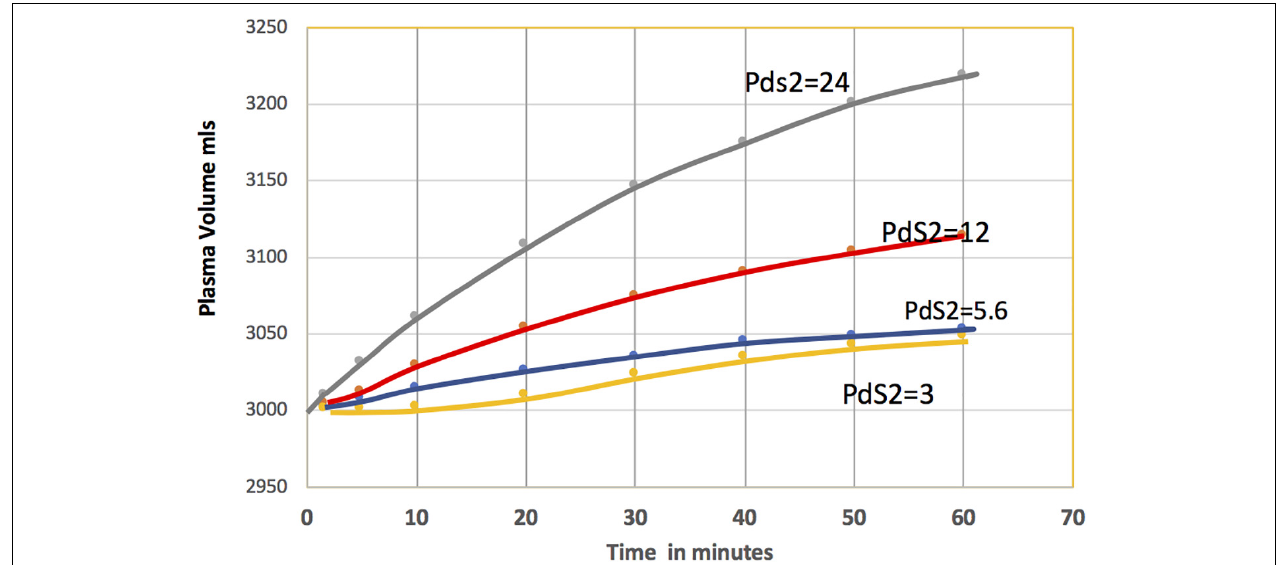
FIGURE 6 | The plasma volume as a function of time is shown for a range of values the PS product for the barrier between the glycocalyx sub-compartment and the sub-compartment in the cleft. The highest resistance to diffusion (10% of total corresponds, PdS2 = 3 ml/min) results in the least volume reabsorbed (orange curve). Reduced resistance increases the volume reabsorbed: 7% of resistance, PdS2 = 5.6 ml/min, blue; 4% of resistance, PdS2 = 12 ml/min, red) and 1% of resistance, PdS2 = 24 ml/min, blue).These results can be compared with Figure 4A where the resistance in the cleft was effectively